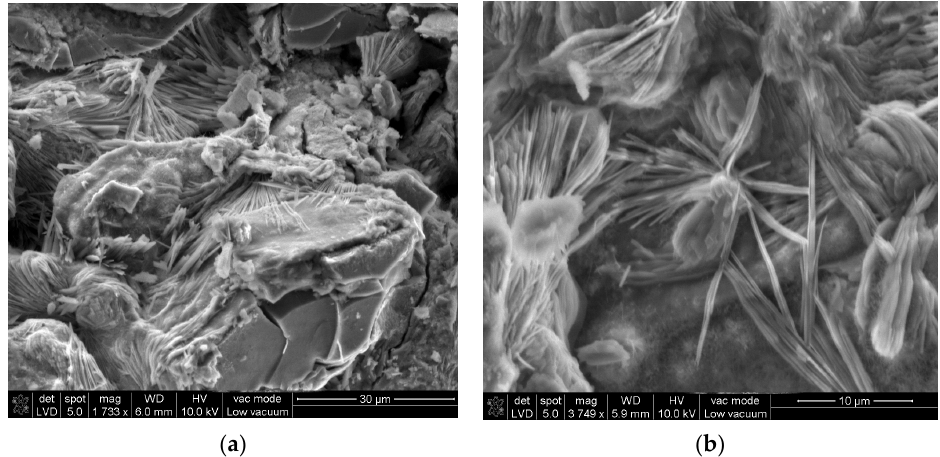
Figure 21. Microstructure of silicate brick modified by glass sand (50%) and quartz sand (50%) observed under a scanning electron microscope (SEM); ( a ) microstructure of the material after 36 months from the laboratory production, 30 μ m magnification; ( b ) microstructure of the material after 36 months from the laboratory production, 10 μ m magnification.